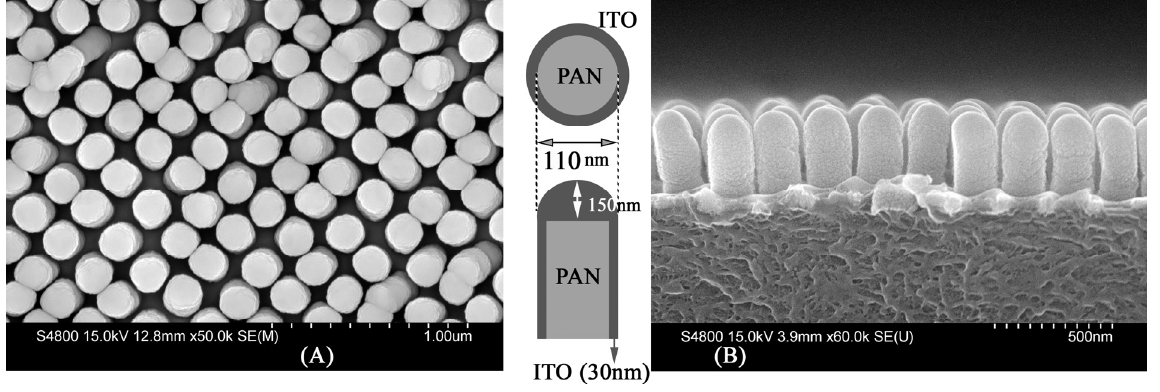
Figure 1. ( A ) top view and ( B ) side view SEM of ITO nanopillar array, inset shows the construction and dimensions of individual